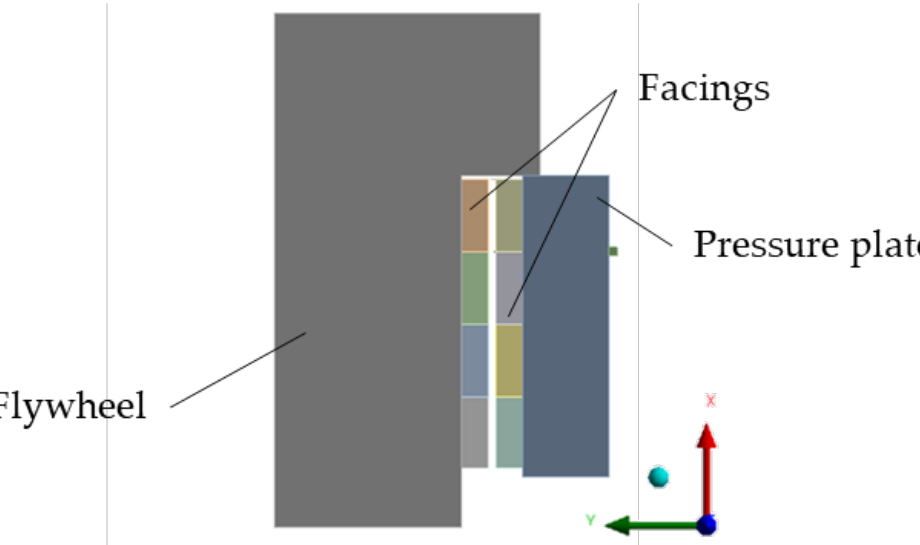
Figure 4. Geometry used in coupled 2D simulation: friction facing pair between simplified flywheel and pressure plate models.